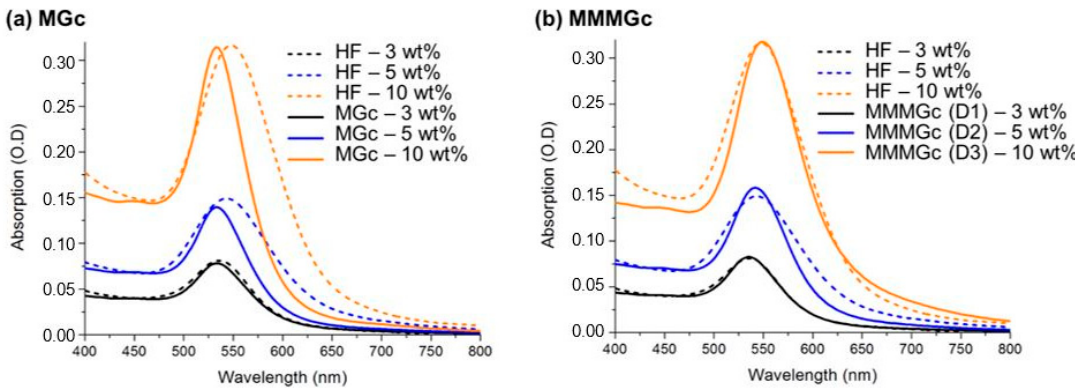
Figure 5. Comparison between the absorption spectra from experiments (dotted line) and simulations (continuous line) using the MGc model ( a ) and the MMMGc model ( b ).